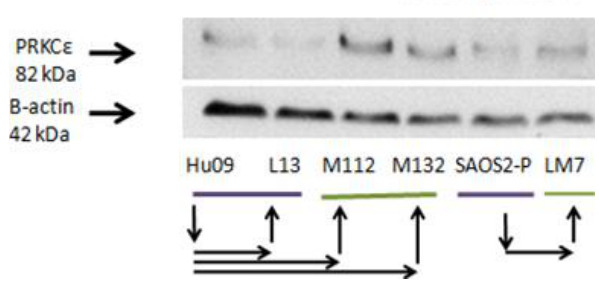
Figure 7. PRKCε Protein is more abundant in some highly metastatic cell line models of osteosarcoma metastasis. Western blots of whole cell lysates from human OS cell lines probed with anti-PRKCε and anti-β-actin antibodies. Purple bars denote cell lines that are poorly metastatic in mouse models, and green bars denote cell lines that are strongly metastatic in cell lines. Arrows denote relationships between cell lines. Shown is a representative western blot of two independent